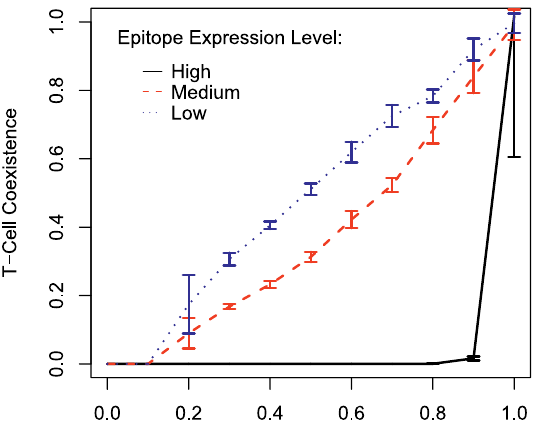
Figure 4. T cell Coexistence Depends on the Relative Affinity of the Immunodominant versus the Subdominant T Cell In the simulations for this plot, the affinity of the immunodominant T cell specificity is set to 0.1, and the affinity of the subdominant is increased from zero to 0.1. The black, red, and blue lines are for high, medium, and low epitope expression levels of 300, 200, and 150 copies of each epitope, respectively. Shown is the mean 6 standard deviation of six replicate simulations. All other parameter settings are listed in Table 1. DOI: